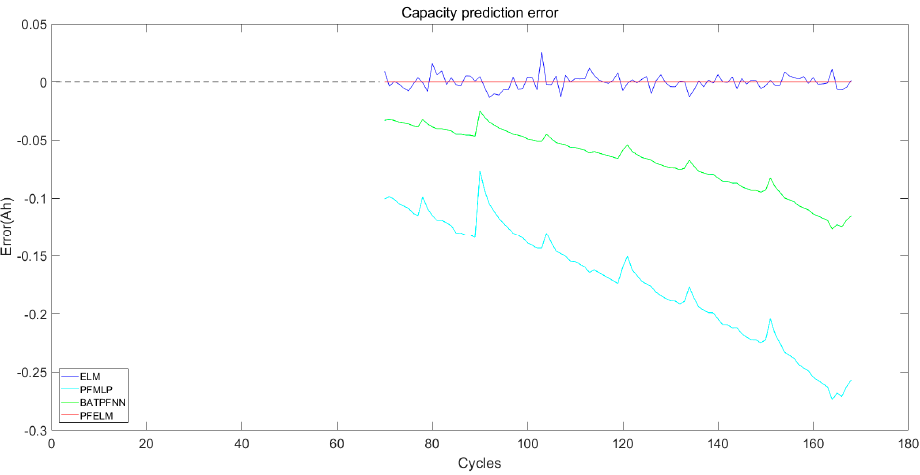
Figure 15. Capacity prediction error from the 70th cycle.